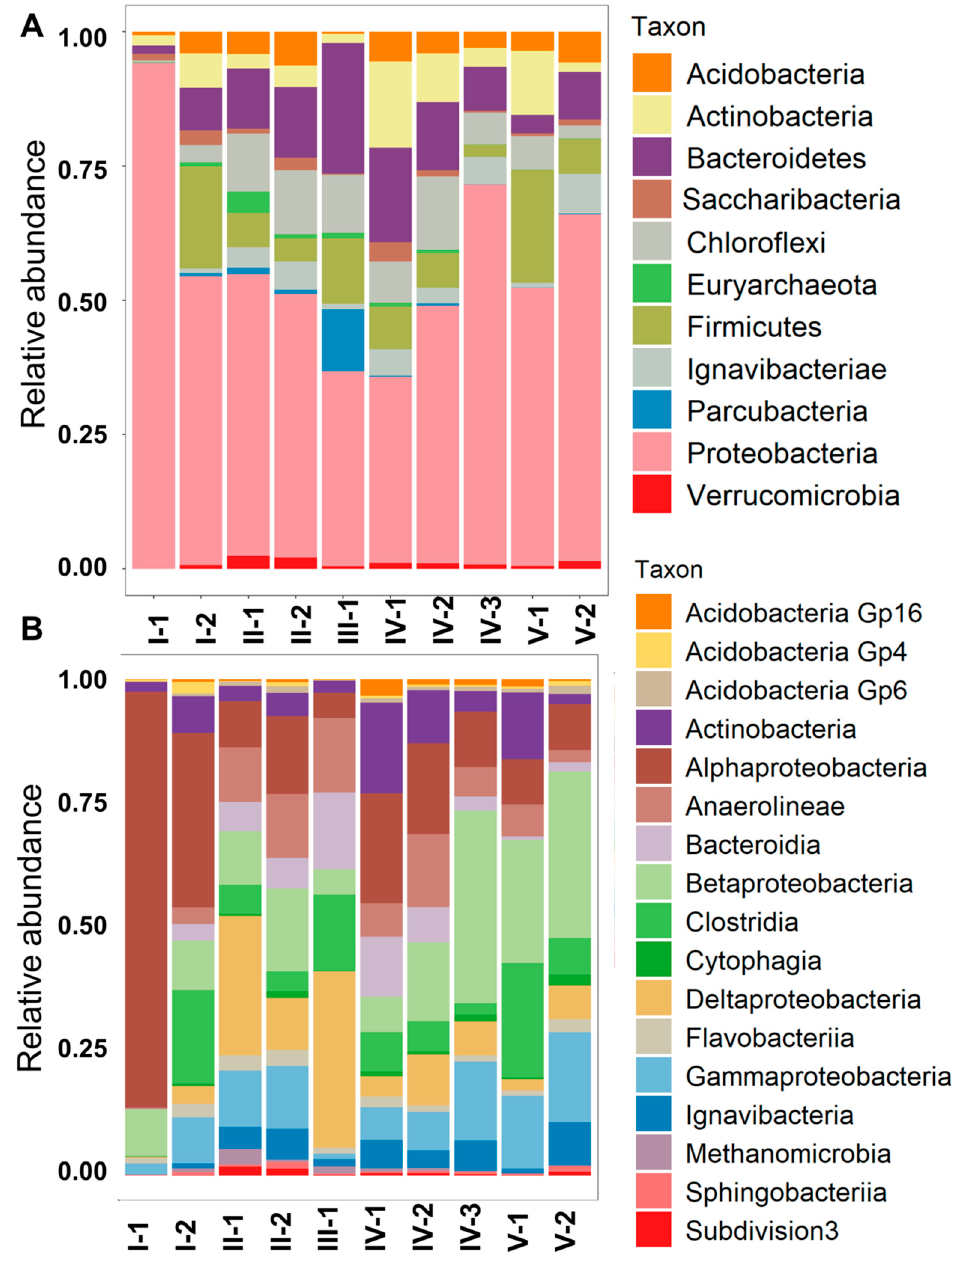
Figure 4. Relative abundances of microbial taxa of considered functional zones of the constructed wetland at the phylum ( A ) and the class ( B ) levels. The data are presented for phyla and classes with abundance of more than 0.5%.